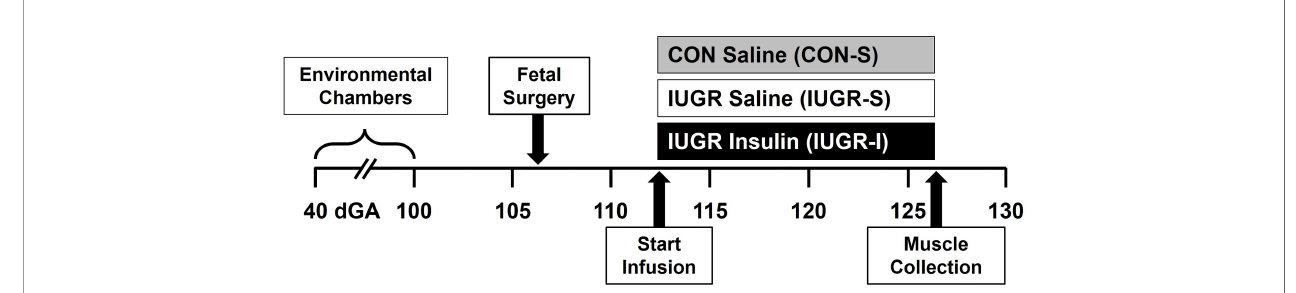
FIGURE 1 | Experimental design. Pregnant ewes were randomly assigned and housed in an environmental chamber from 41 ± 2 to 99 ± 1 days gestation (dGA) with either elevated temperatures (40°C for 12 hrs; 35°C for 12 hrs; 35-40% humidity) to produce placental insuf fi ciency and IUGR, or with ambient temperature (21°C for 24 h; 35-40% humidity) as control (CON). After surgical procedure (106 ± 1 dGA) and recovery, CON fetuses received saline (CON-S, n=6, grey) while IUGR fetuses received either saline (IUGR-S, n=7, white) or insulin infusion (IUGR-I, n=11, black) for 14 days starting on 112 ± 1 dGA. Muscles were collected at necropsy on 126 ±